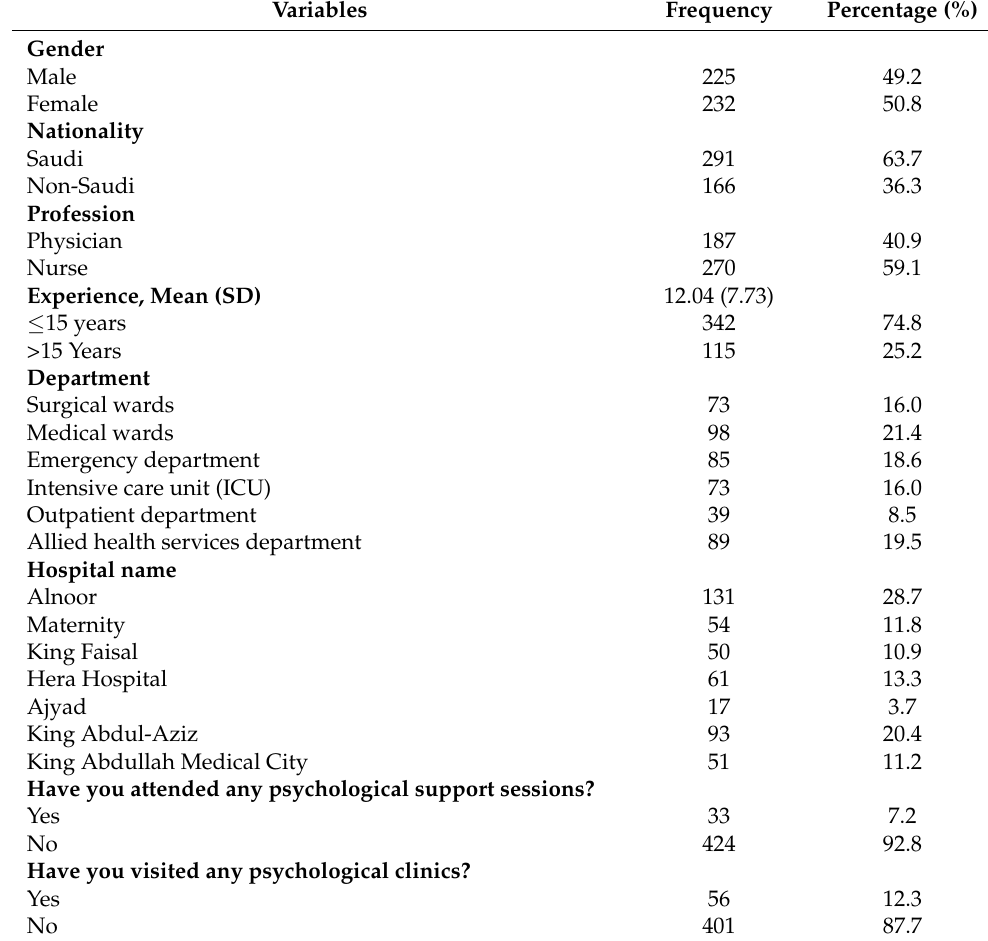
Table 1. Distribution of Socio-demographic Characteristics of the Participants (N =